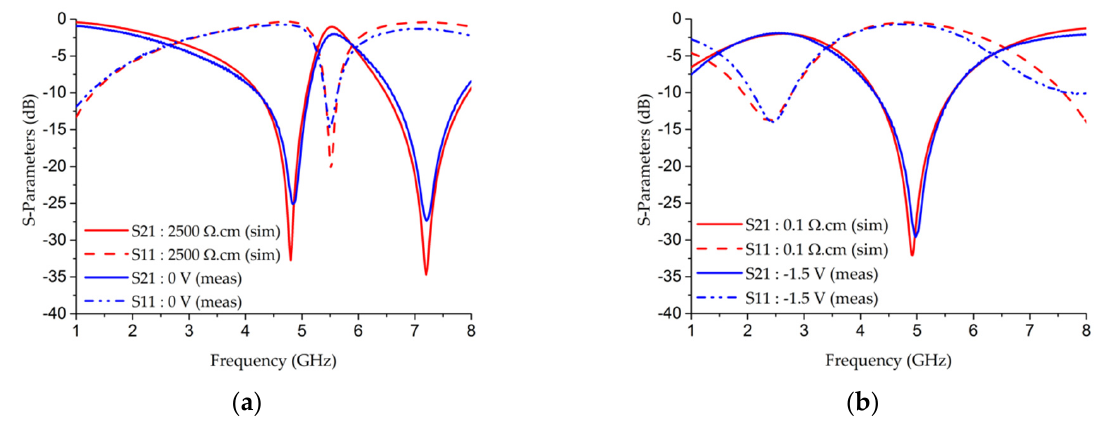
Figure 8. Comparison of simulated and measured results of switchable DBR 1 . ( a ) in the OFF state; ( b ) in the ON state.